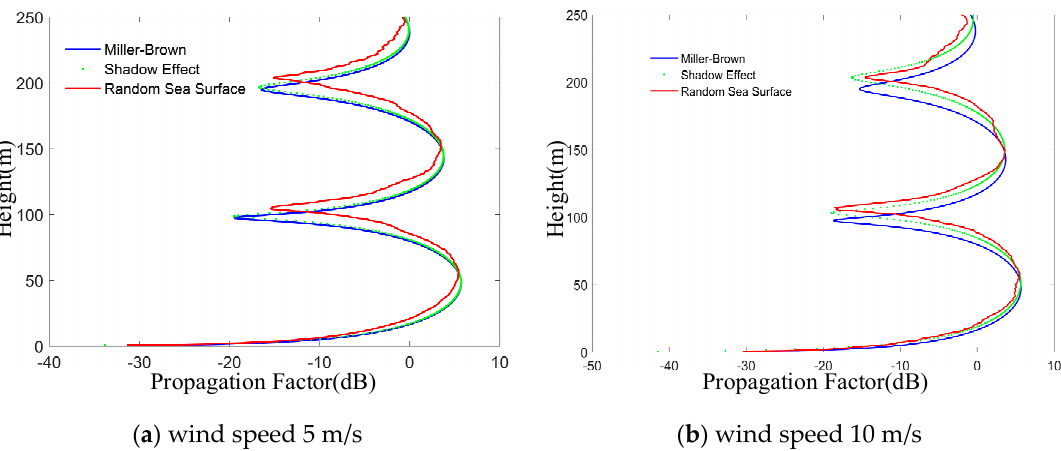
Figure 17. Effects of sea surface wind speed by three methods. ( a , b ) are the wind speed 5 m/s and 10 m/s, show a comparison of the propagation factors on Miller-Brown model, shadow effect model and random sea surface model at different wind speeds.